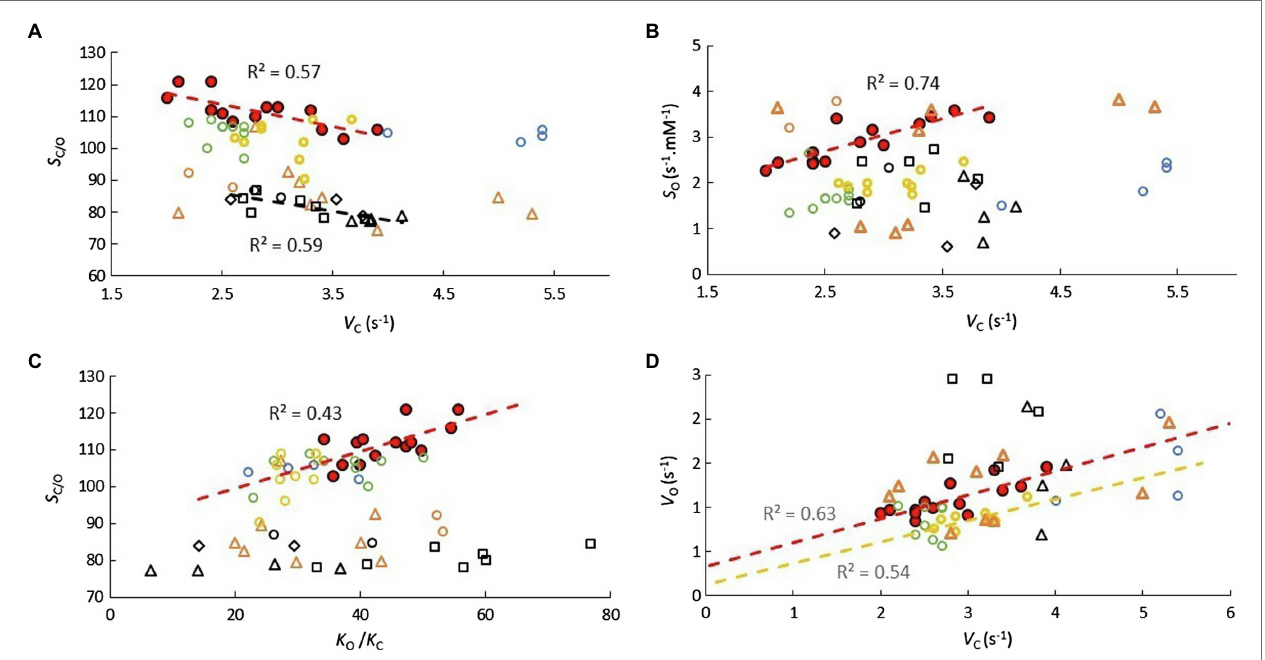
and oxygenase reactions. As indicated in Figure 6 , V max , m and b share a number of k i associated with product turnover, while only m and b depend on the k i that determine substrate affinity. Correlations between kinetic traits arising out of RuBisCOs mechanism must derive from correlations between the k i . However, the k i are unknown quantities, difficult if not impossible to determine empirically with any certainty, and without simplifying assumptions (Tcherkez et al., 2006), complexity of the functional relationships hinders efforts to uncover such correlations (for details of the actual kinetic equations, see Cummins et al., 2018a). Nevertheless, several important observations can be made based on the results of the present analysis. The absence of correlation between S C and V C in the C 3 sample ( Figure 1B ) demonstrates that the k i on which V C depends are not correlated to that associated with CO 2 affinity for enolized RuBP ( k 5 ). When mV C >> b , S C converges asymptotically to the mean value for the sample. Compared to C 3 Limonium and C 4 plants, S C converges very quickly to this mean value for the C 3 sample ( Table 1 ), and so the dependence of K C on b , which depends on the decarboxylation rate ( k 6 ), may be neglected. This would suggest a lesser significance of k 6 in C 3 species, resolving to some extent the apparent differences of opinion on the issue of decarboxylation (Tcherkez et al., 2018; Cummins et al., 2019a). Nevertheless, the results suggest significant ( mV max ≈ b ) decarboxylation in both C 3 Limonium and C 4 samples ( Figure 1A ) and deoxygenation ( k 12 , i.e., breakdown of the Michaelis complex by dissociation of O 2 ) in all three ( Figure 1C ).